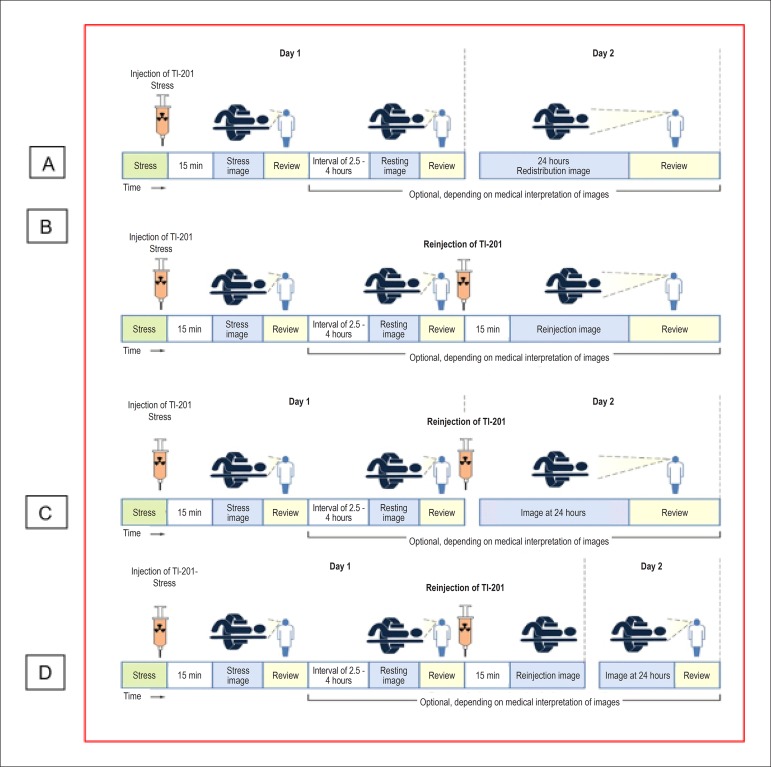
Imaging protocols with the use of thallium-201 (201Tl) for characterizing viability of the myocardium. A represents the classic sequence for defining ischemia (Day 1), with the injection of a dose of approximately 3 to 4 mCi during stress, without subsequent reinjection, adding new image acquisition 24 hours later (Day 2); B, C, and D emphasize the need for reinjection of 201Tl with an approximate dose of 1 mCi and sequencing as demonstrated in the proposed protocol.